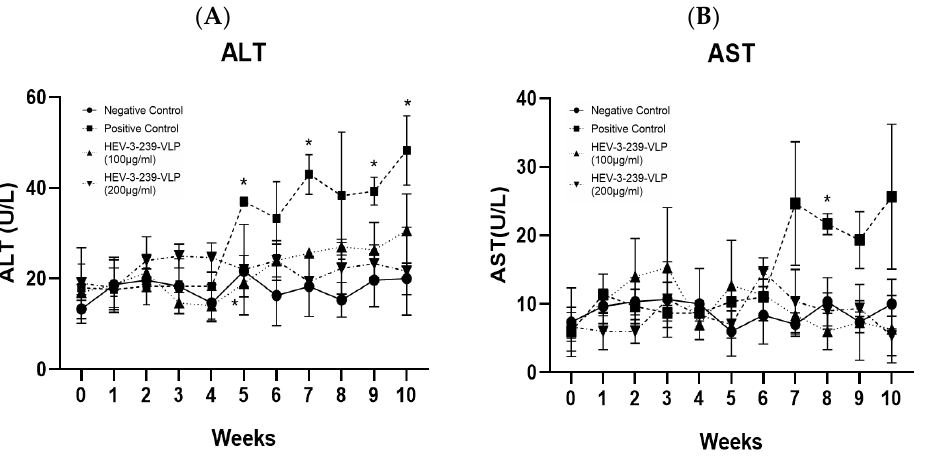
Figure 4. ALT value in the serum from all the pigs every week. ( A ) The ALT value of the negative control group was maintained at around 20 U/L. In contrast, the ALT value of the positive control group started to increase significantly at week 5 and exceeded the normal range (8.18–40.29) at week 7. The ALT value of the two vaccinated groups was maintained similar to the ALT value of the negative control group. ( B ) AST value in serum from all pigs for every week. The AST value of the negative control group was maintained at around 10 U/L. In contrast, the AST value of the positive control group started increasing at week 7 and remained relatively high compared to the values of other groups. The AST value of the two vaccinated groups was maintained similar to the AST value of the negative control group. The statistical analysis was conducted between the positive and negative control pigs and the vaccinated pigs and the negative ones. * p < 0.05.